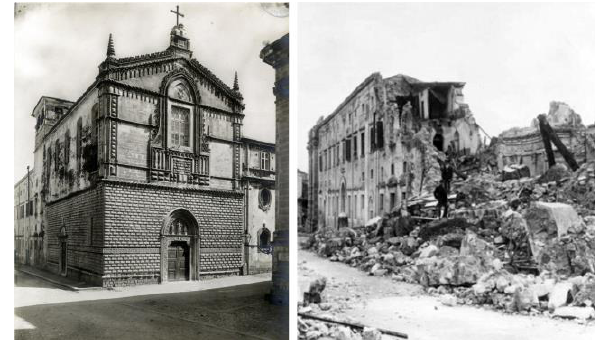
Figure 1 . Santa Maria della Scala.